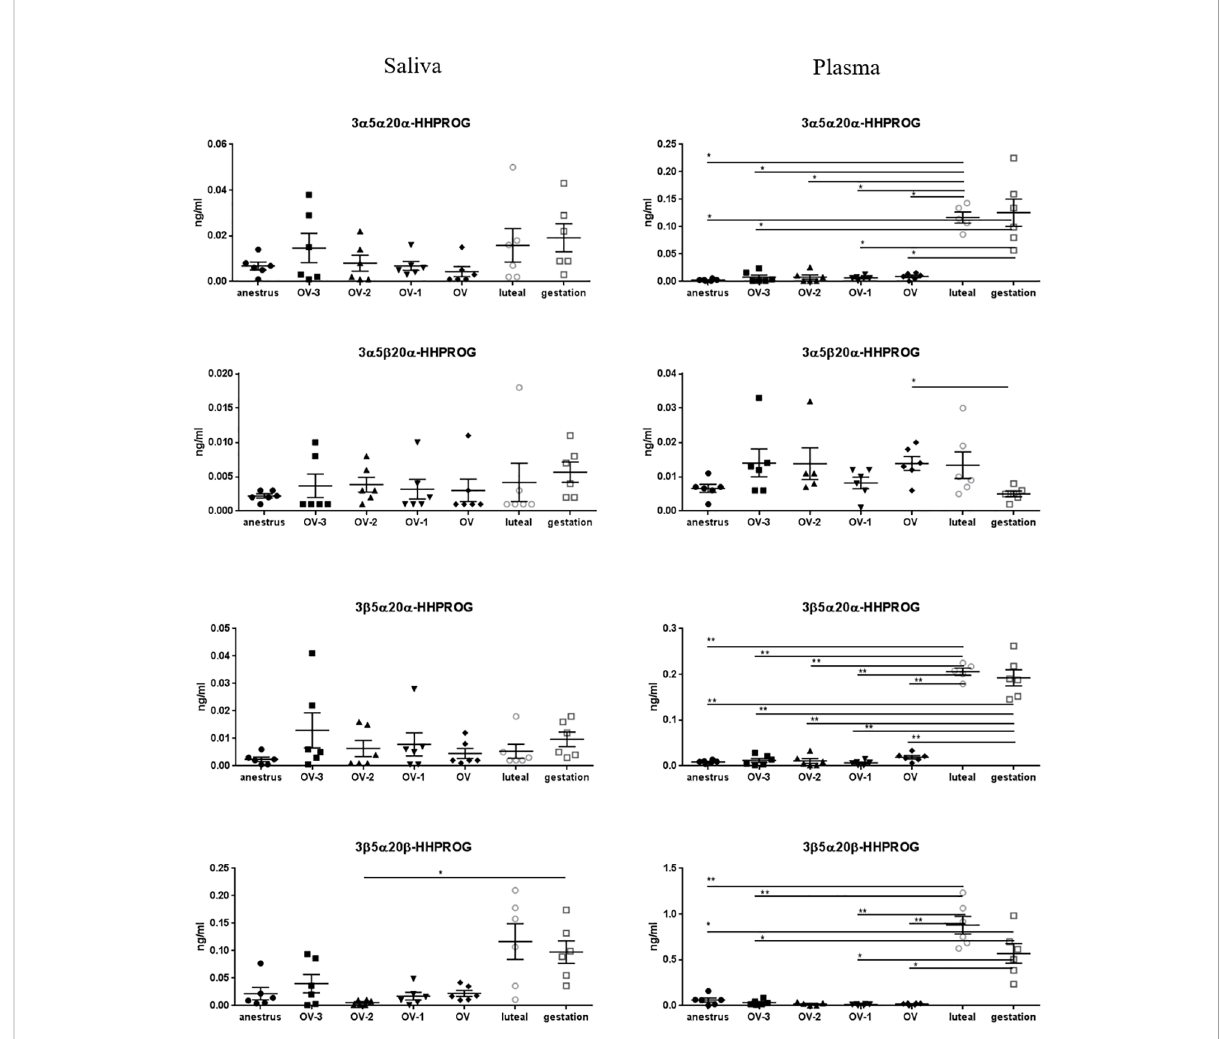
FIGURE 4 Gas chromatography coupled to tandem mass spectrometry (GC-MS/MS) measurements of the concentrations of 3 a 5 a 20 a - hexahydroprogesterone (3 a 5 a 20 a -HHPROG), 3 a 5 b 20 a -HHPROG, 3 b 5 a 20 a -HHPROG and 3 b 5 a 20 b -HHPROG (ng/mL ± SEM) in mare saliva and plasma collected during anestrus, during follicular phase 3 days (OV-3), 2 days (OV-2) and 1 day (OV-1) before ovulation, the day when ovulation was detected (OV), during luteal phase 6 days post-ovulation (luteal), during gestation 18 days post-ovulation (gestation). For each steroid, the y-axis was standardized to the maximal concentration, so that the variations are easy-to-read. Statistical differences between physiological stages: * P < 0.05, ** P <